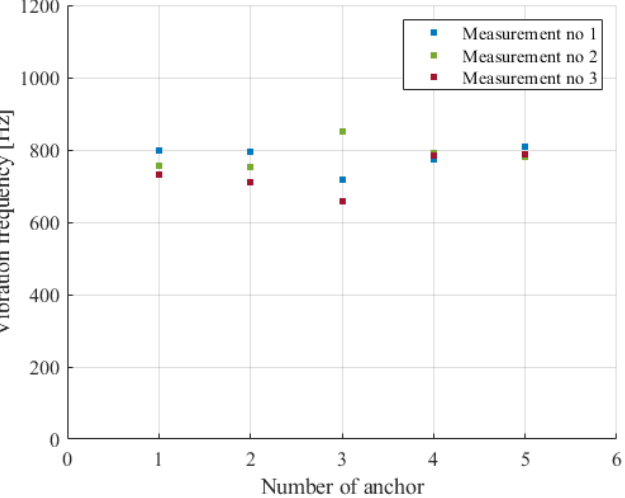
Figure 14. Measurement of anchor vibration frequency in a Vernier longitudinal with filtration.